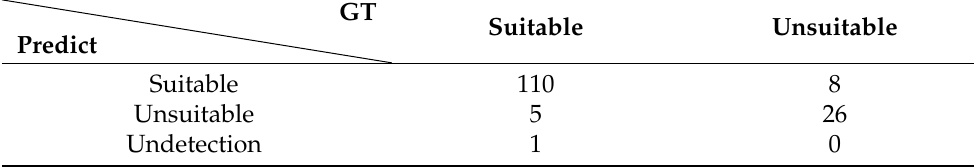
Table 4. The confusion matrix of diagnosis (external val.).